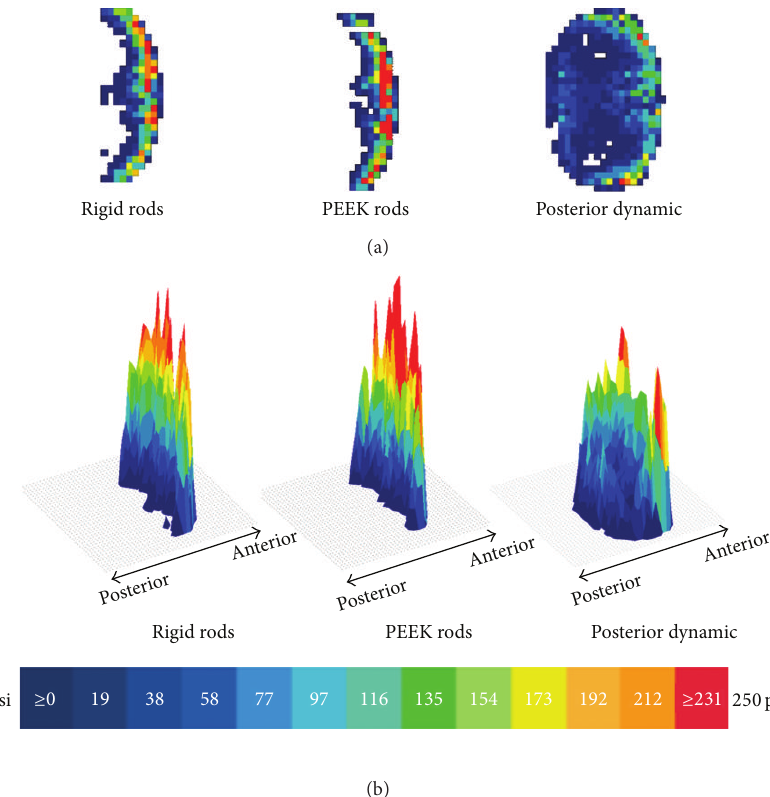
Figure 7: Example of pressure film data showing pressure contact area of spacer with blue colors representing low pressures and red colors representing high pressures, in two dimensions (a) and three dimensions (b) for each posterior instrumentation